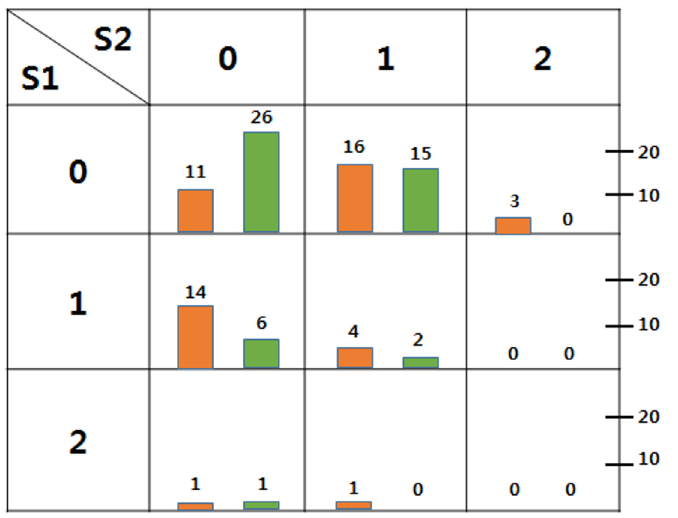
Fig 4. Toy example dataset structure to show superiority of the stepwise CMH method. We counted the numbers of cases and controls for each genotype combination and expressed them as vertical bars to visualize. Orange bars represent the counts of cases and the green bars do counts of